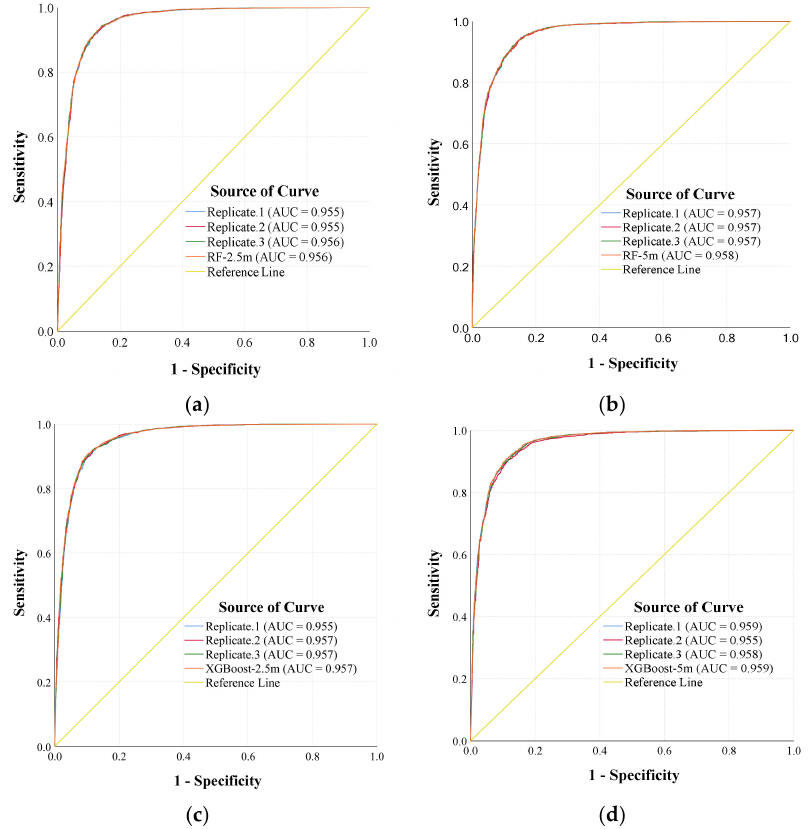
Figure 6. Evaluation of the robustness of data sets with a resolution of 2.5–5 m. ( a ) RF—2.5 m. ( b ) RF—5 m. ( c ) XGBoost—2.5 m. ( d ) XGBoost—5